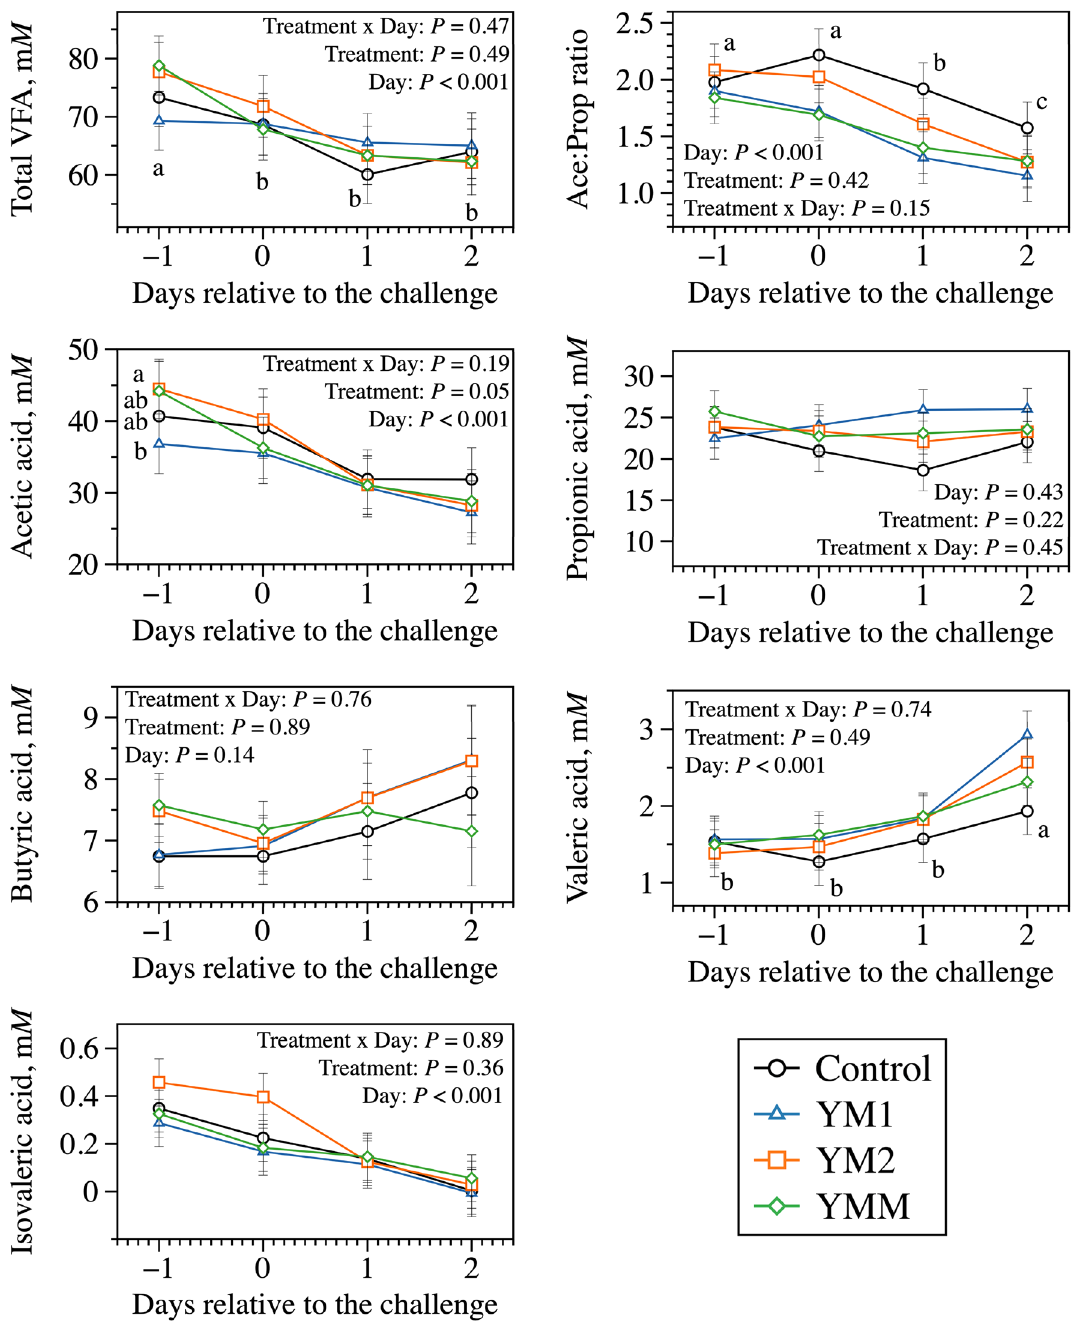
Figure 3. Dynamics of volatile fatty acids (VFA) concentration after the morning feeding on days 8, 9, 10, and 11 of each period to represents the days − 1, 0, 1, and 2 relative to the challenge; day 7 was used as a covariate to the model. All treatments had the same basal diet (1 mL of each DFM was applied per day at 1 × 10 8 cfu/mL); treatments were: Control, carrier of additives without DFM; YM1, S. cerevisiae and M. elsdenii strain 1; YM1, S. cerevisiae and M. elsdenii strain 2; YMM, S. cerevisiae and M. elsdenii strain 1 (1/2 dose) and strain 2 (1/2 dose). Statistical differences were declared at P ≤ 0.05 or as a trend to be different if P > 0.05 and <